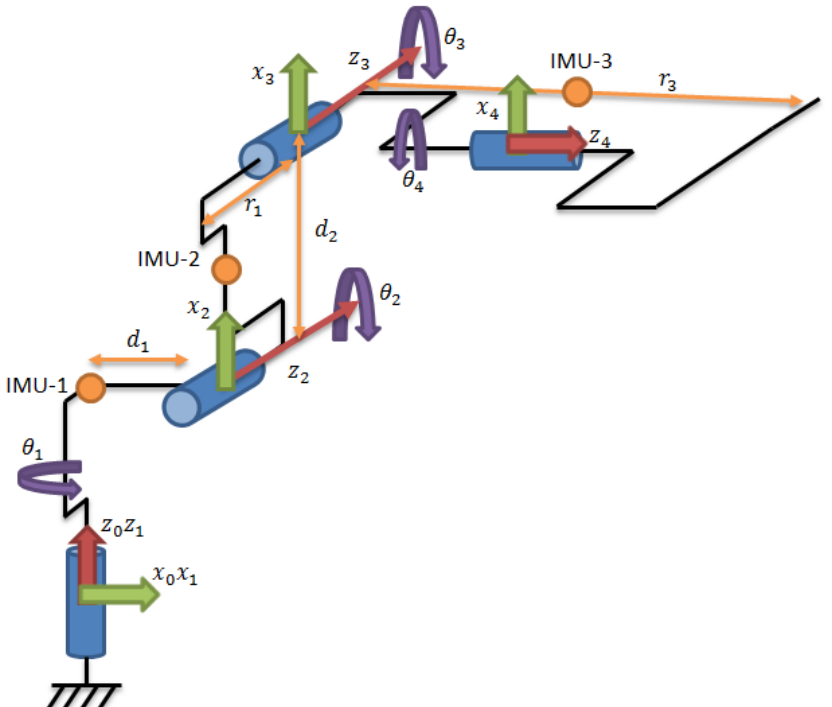
Sensors 2022 , 22 , x FOR PEER REVIEW 5 of 19 Figure 2. Placement of IMU sensors on the robot. Figure 2. Placement of IMU sensors on the robot.